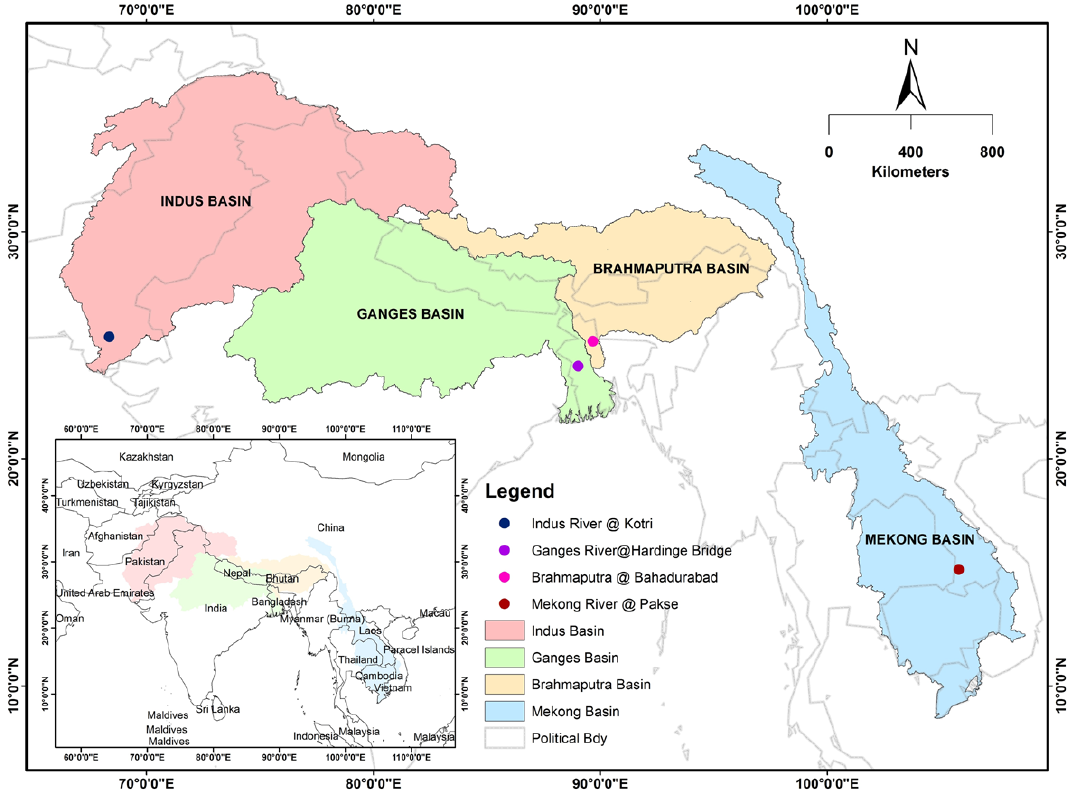
Fig. 1. The four river basins considered in this study: Indus, Ganges, Brahmaputra and Mekong (west to east).